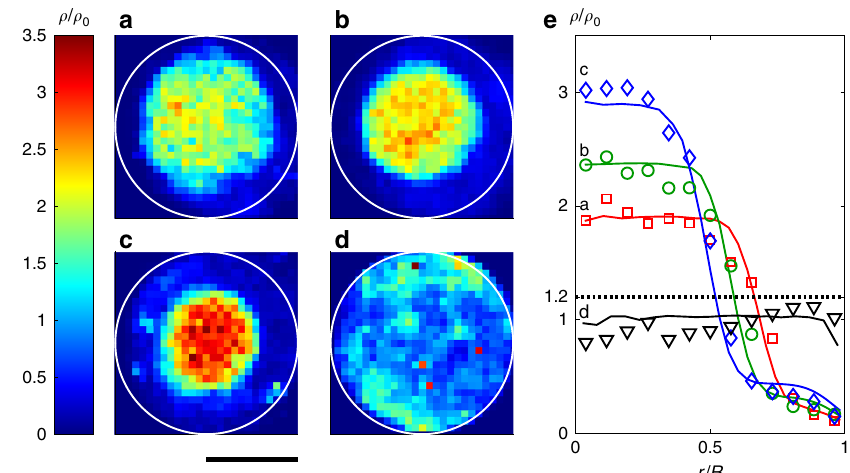
in the steady-state for concentration threshold 0 ¼ 1 : 2 which de fi nes the threshold for the de fi nition of a 0